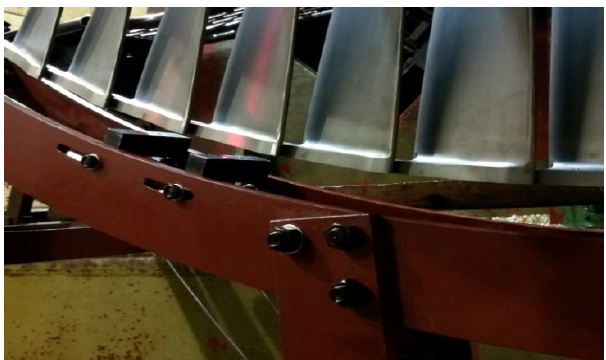
Figure 7. Installations of fiber optical sensors.